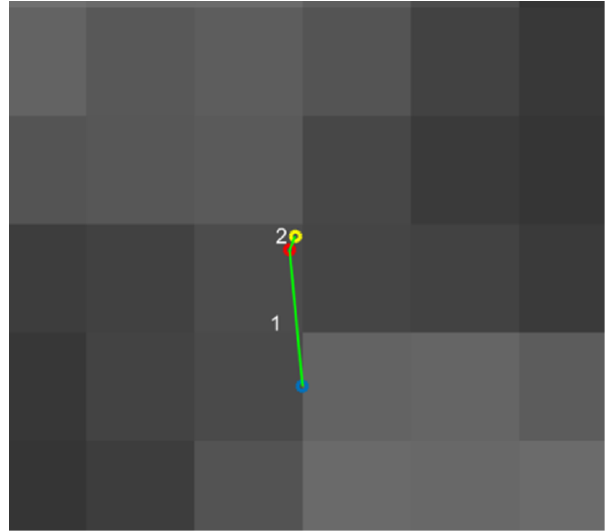
Figure 4. The iterative process of extracting corner points starting from the result of the Harris detection algorithm (blue point).